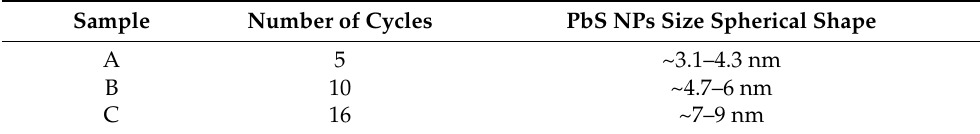
Table 2. Summary of PbS NPs sizes deposited for different numbers of cycles.